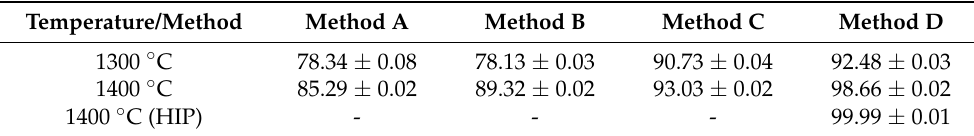
Table 2. Relative density (% theo) of the sintered samples.